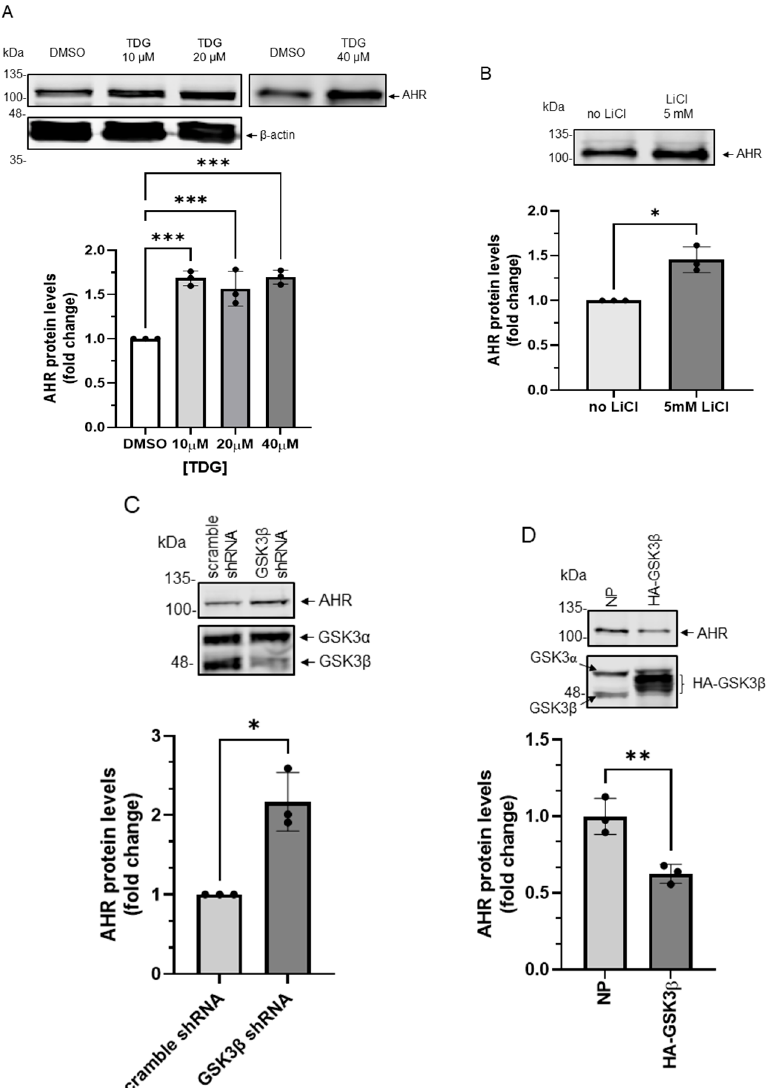
Figure 2. AHR protein levels are regulated by GSK3 β in HeLa cells. ( A ) HeLa cells were treated with 10 µ M, 20 µ M or 40 µ M TDG for 8 h. Western blot analysis showed that AHR protein levels increased after TDG treatment. The images are representative of the replicate data (means ± SD, n = 3, *** p < 0.001). DMSO group (treated for 8 h) was arbitrarily set as one (with no error bar) for data normalization. One-way ANOVA with Dunnett multiple comparisons test was performed to determine statistical significance. ( B ) AHR protein levels increased after 5 mM LiCl treatment for 6 h. The images are representative of the replicate data (means ± SD, n = 3, * p < 0.05). No LiCl (no treatment) group was arbitrarily set as one (with no error bar) for data normalization. Unpaired t -test with Welch’s correction was used to determine the statistical significance. ( C ) Transient knockdown of GSK3 β (after 72 h) increased AHR protein levels. The images are representative of the replicate data (means ± SD, n = 3, * p < 0.05). Cells transfected with scramble shRNA were used as the negative control and was arbitrarily set as one (with no error bar) for data normalization. Unpaired t -test with Welch’s correction was used to determine the statistical significance. ( D ) Transient expression of HA-GSK3 β (after 72 h) decreased AHR protein levels. The images are representative of the replicate data (means ± SD, n = 3, ** p < 0.01) in one experiment and was repeated two more times with similar results. No plasmid group (NP) represents cells undergoing the same transient transfection without a plasmid. Unpaired t -test was used to determine the statistical significance. For A to D, each Western lane contained 30 µ g of whole-cell lysate. Data in A for 10-20 µ M treatment groups were normalized by β -actin (as shown) whereas the rest of the data were normalized by total protein